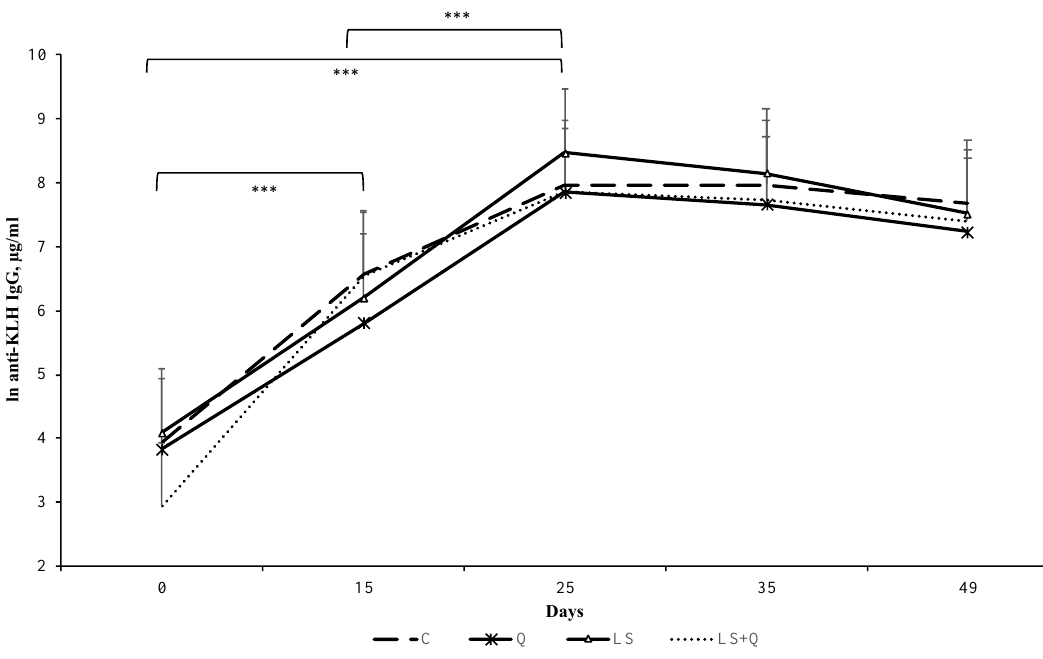
Figure 1. Antibody titers to KLH (Least Squares means ± SEM) detected at 0, 15, 25, 35 and 49 day of the experiment in blood of lambs as affected by different diet supplementation (C = control; Q = quinoa seed; LS = linseed; LS + Q = linseed + quinoa). *** = p < 0.001. Anti-KLH IgG production was affected by time of sampling ( p < 0.001). Each of experimental group registered an increase from starting time, to 15 and to 25 day of the experiment on the anti- experimental groups was registered.